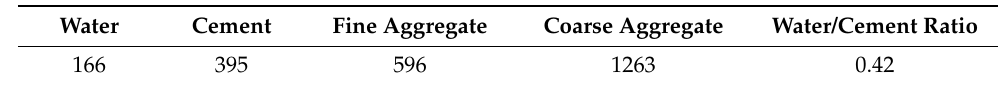
Table 3. Mix of the concrete (kg/m 3 ).